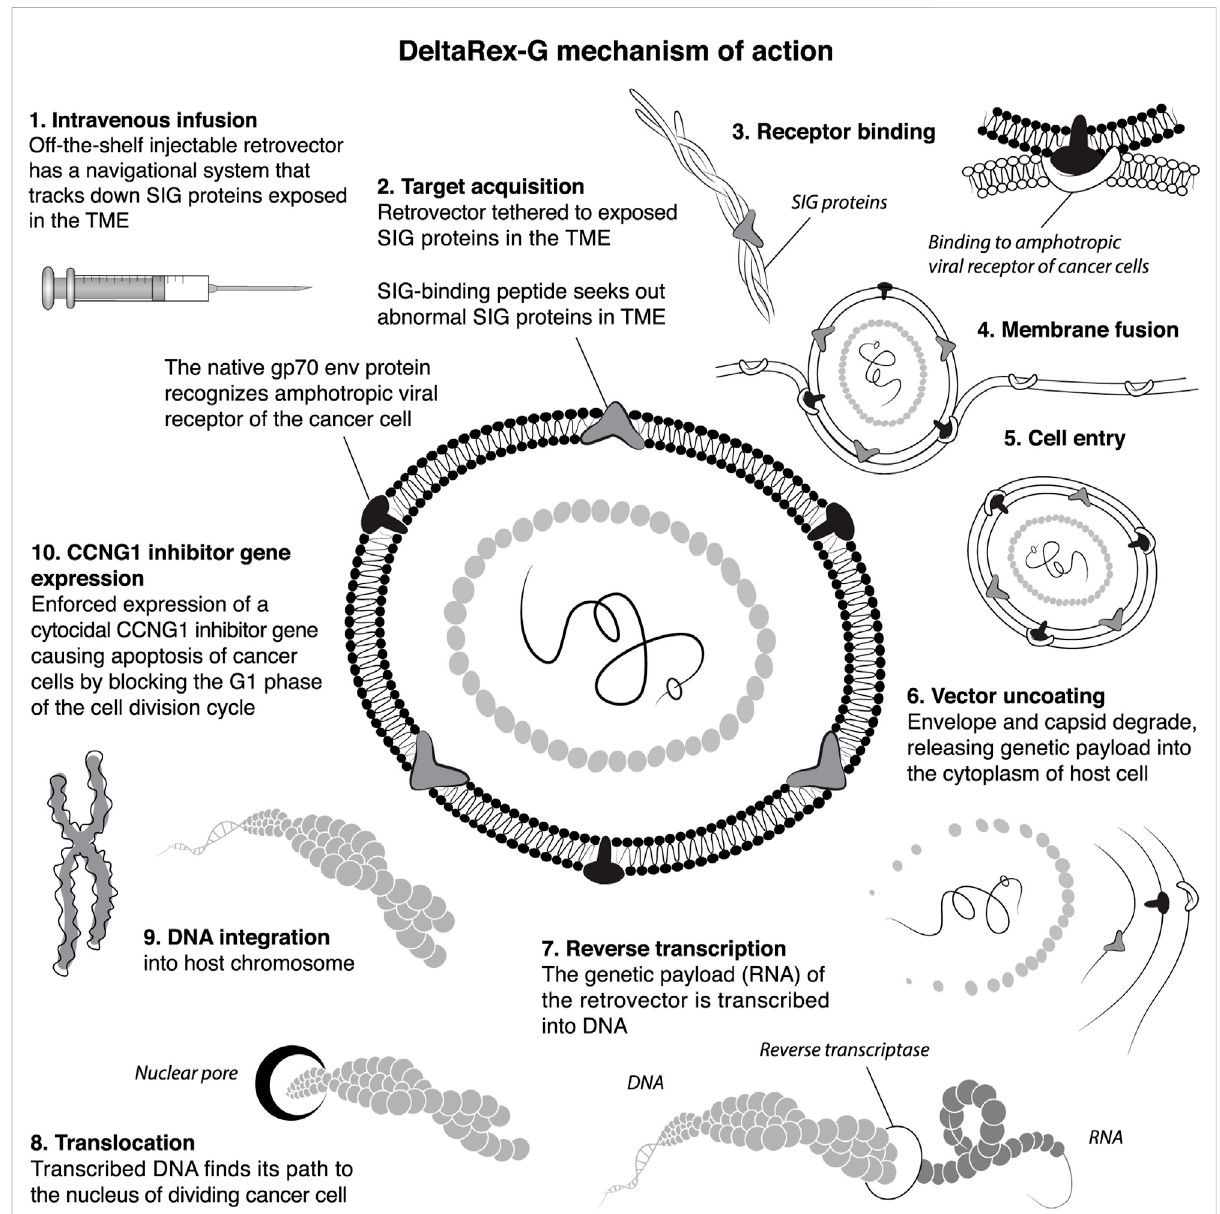
FIGURE 1 A Diagramatic ten-step illustration of DeltaRex-G tumor targeting mechanisms of action. The DeltaRex-G nanoparticle displays a pan- collagenousSIG-bindingpeptidederivedfromvWFcoagulationfactoronitsgp70envelopeprotein.Wheninjectedi.v.,DeltaRex-Gseeksouttumors andaccumulates incancerous lesions bybindingtoabnormalSIGproteins exposedintheTMEasaresult oftumorinvasion processes. Thistargeted retrovectorhastheinnatepropertyofMLVbindingtothenaturalamphotropiccellreceptor,fusing,entering,uncoatingandintegratingintothe chromosomes of actively dividing cells only (i.e., cancer cells), while sparing normal cells. DeltaRex-G bears a cytocidal dominant-negative Cyclin G1inhibitoryconstruct,whichcausescelldeaththroughapoptosis. CCNG1 ,cyclinG1;SIG,abnormalsignatureproteins;vWF,vonWillebrandfactor; TME, tumor microenvironment (Morse et al.,